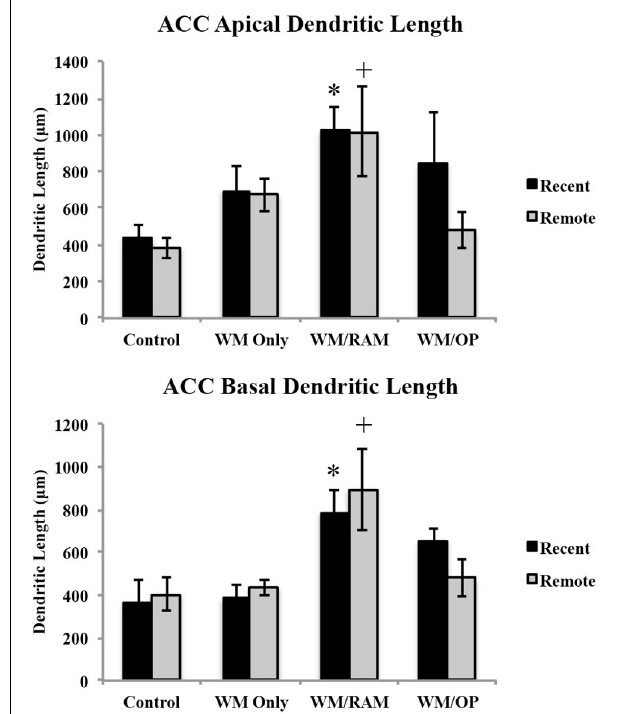
FIGURE 5 | Total dendritic length in the ACC in apical and basal dendrites. Only significant differences between behavioral groups and their respective control group are displayed. Refer to Results section for all comparison results. ∗ Significantly different from Control:recent group ( p < 0 . 05); + Significantly different from Control:Remote ( p < 0 .